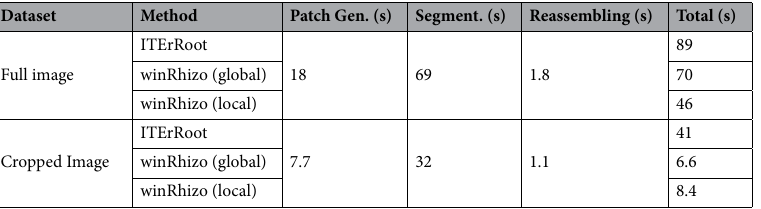
Table 7 outlines results from ITErRoot , IterNet , and SegRoot each trained on the training set containing 1,069 extra empty patches from trial 2. We can see that our model excels on each dataset, except in a few cases where the specificity score from IterNet is slightly higher (but for those cases the Mean Dice, accuracy and sensitivity scores are still higher for ITErRoot ). It is important to note that the majority of the pixels in the ground truth masks are background, and so specificity is expected to be high in most cases. Both IterNet and SegRoot had Dice scores that were similar or better on the cucumber images compared to the validation and test images, while ITErRoot saw a small reduction in segmentation quality on the cucumber set. This shows that, while they may not be as good at segmenting roots specifically, these other models are better at more general segmentation of an image. Figure 13 shows an example input image and the resulting segmentations of each of the approaches compared here. The extremely high specificity of ITErRoot relative to comparators likely arises from the IterNET-like